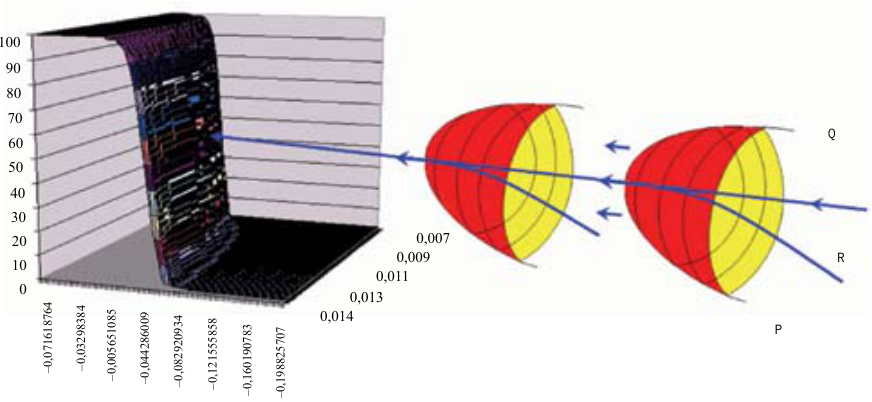
Fig. 3. Possibilities set and utility function in three-dimensional